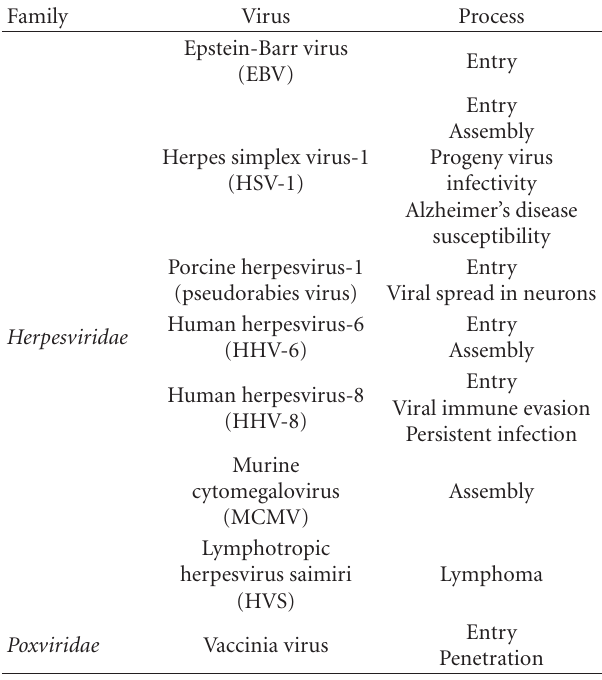
Table 2: Function of membrane rafts in enveloped RNA